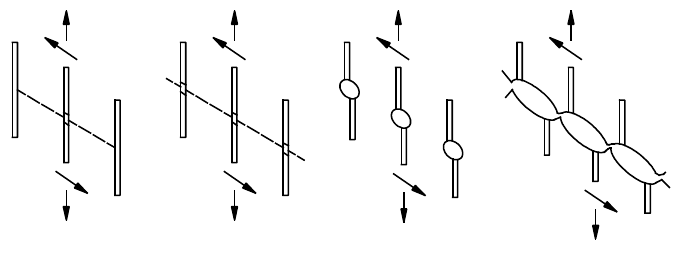
Figure 11. Miller–Smith mechanism [25].